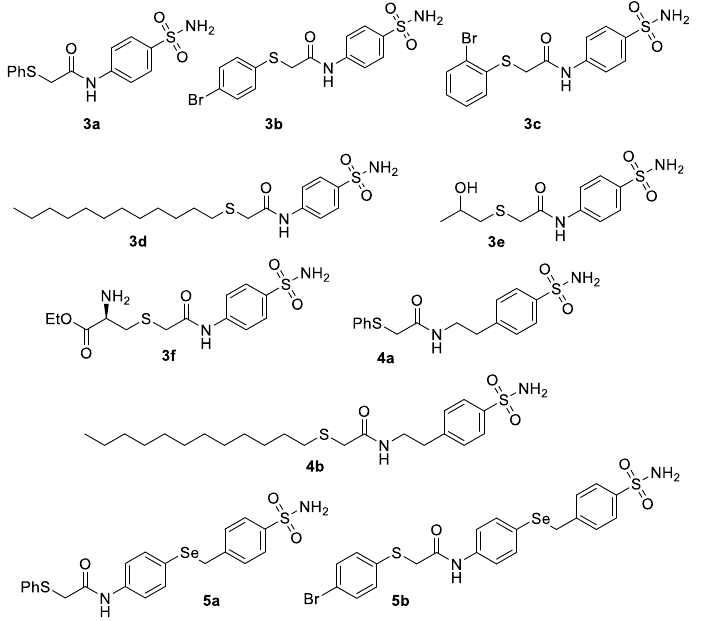
Figure 1. Sulfur-containing acetamides bearing the benzenesulfonamide moiety.